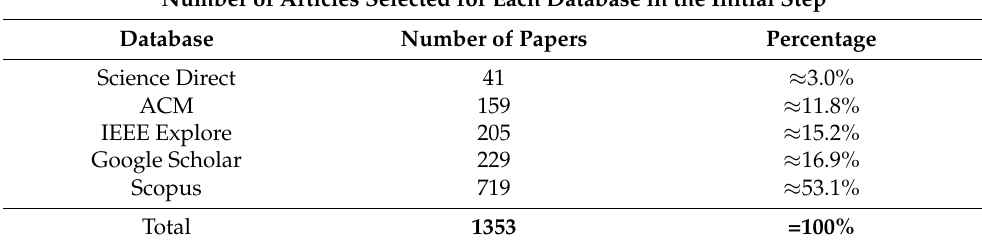
Table 5. Number of articles selected for each database in the initial